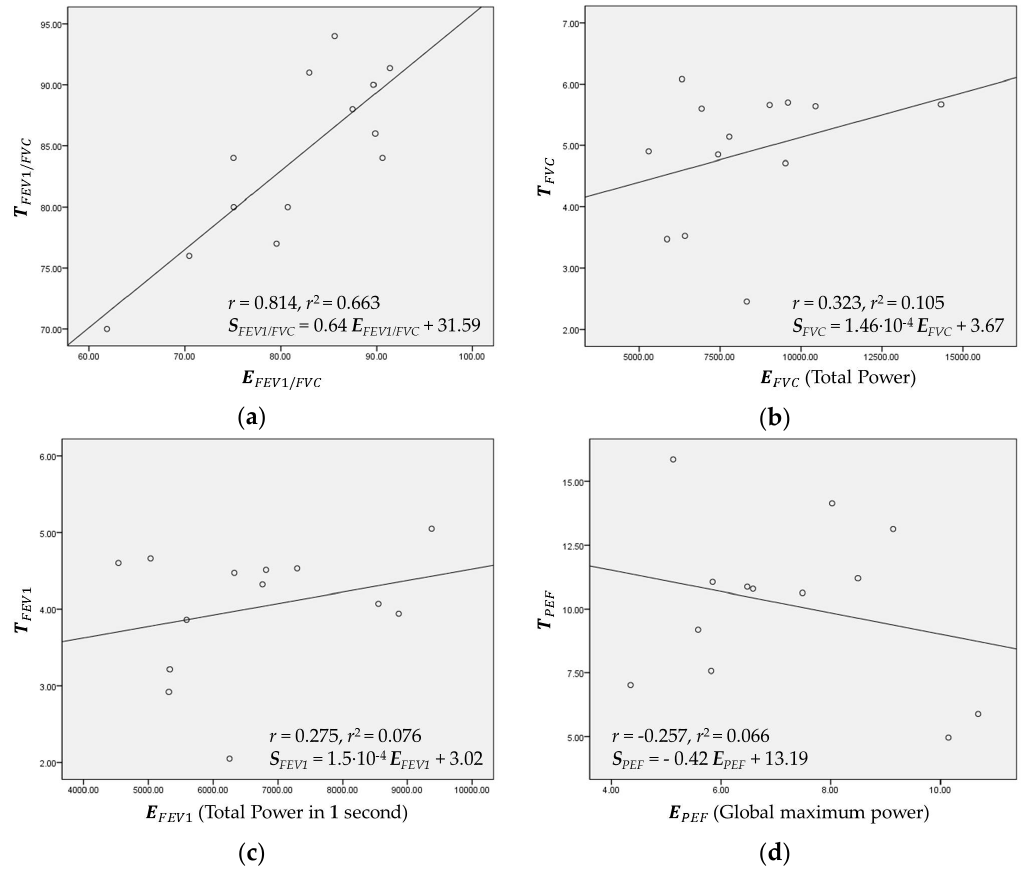
Figure 7. Regression plots of: ( a ) (cid:1831) (cid:2890)(cid:2889)(cid:2906)(cid:2869)/(cid:2890)(cid:2906)(cid:2887) vs. (cid:1846) (cid:2890)(cid:2889)(cid:2906)(cid:2869)/(cid:2890)(cid:2906)(cid:2887) , ( b ) (cid:1831) (cid:2890)(cid:2906)(cid:2887) vs. (cid:1846) (cid:2890)(cid:2906)(cid:2887) , ( c ) (cid:1831) (cid:2890)(cid:2889)(cid:2906)(cid:2869) vs. (cid:1846) (cid:2890)(cid:2889)(cid:2906)(cid:2869) ; and Figure 7. Regression plots of: ( a ) E FEV1/FVC vs. T FEV1/FVC , ( b ) E FVC vs. T FVC , ( c ) E FEV1 vs. T FEV1 ; and ( d ) (cid:1831) (cid:2900)(cid:2889)(cid:2890) vs. (cid:1846) (cid:2900)(cid:2889)(cid:2890) . ( d ) E PEF vs. T PEF